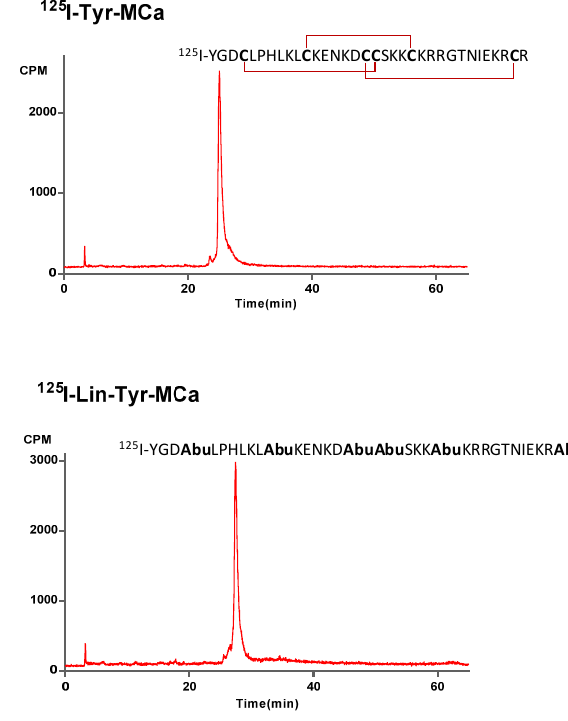
Figure 1. 125 I-Tyr-MCa and 125 I-Lin-Tyr-MCa peptidic sequences and RP-HPLC profiles following radiolabeling. Table 1. In vitro blood distribution patterns of radioactivity following 125 I-Tyr-MCa and 125 I-Lin-Tyr-MCa incubation with whole murine blood.